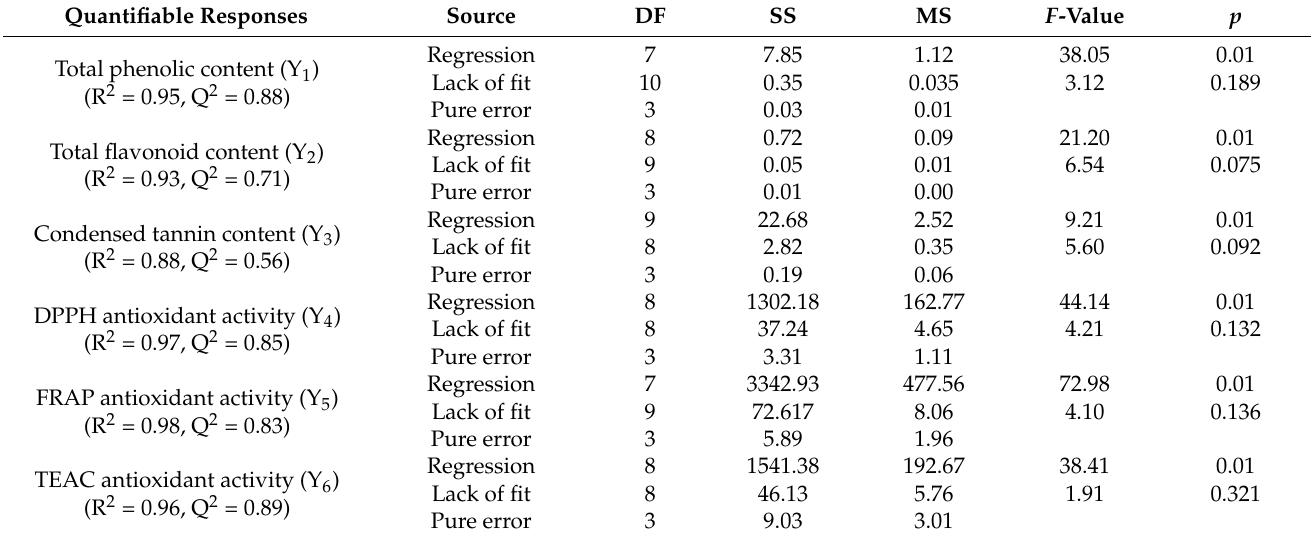
Table 3. Optimization of extraction